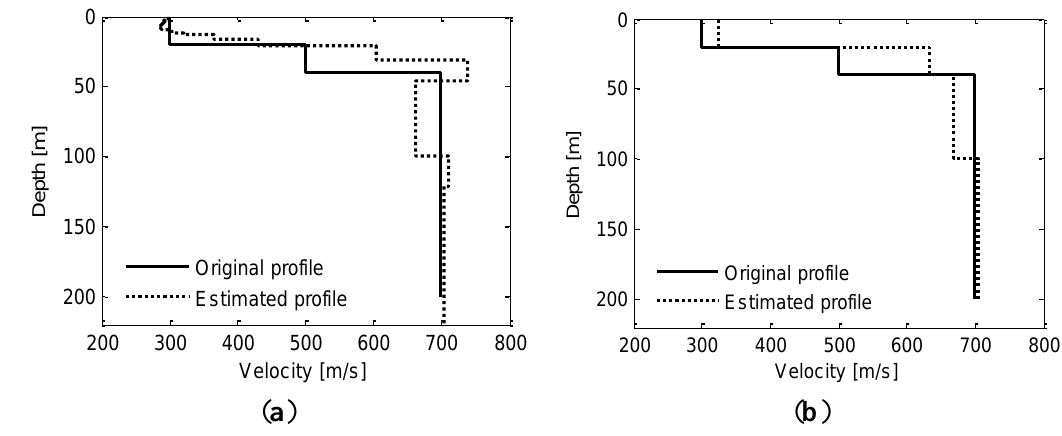
Figure 9. Inverted shear velocity profile vs. original profile for ascending stiffness profile; ( a ) Inverted shear profile; and ( b ) Averaged shear